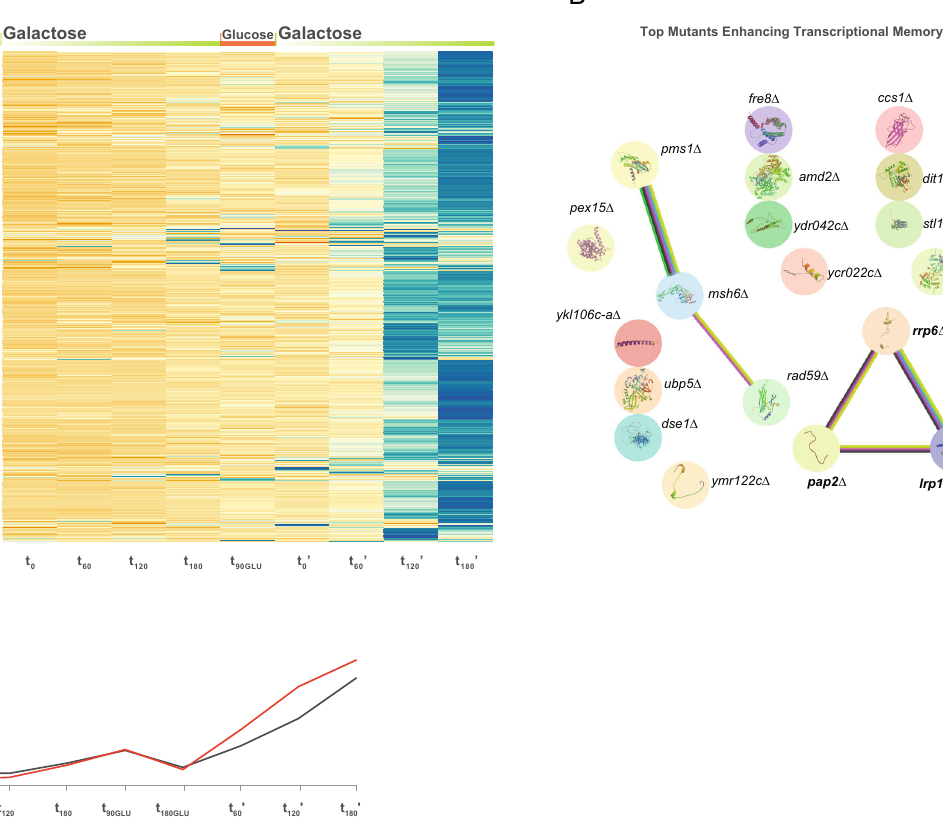
determined, green indicate predicted interaction as gene neighborhood, light greenindicatesourceastextmining,blackindicateco-expression. C RelativesfGFP expression for components of the nuclear exosome in red line ( rrp6 Δ ) relative to wild type in black line (y-axis from 1 (all cells with no detectable GFP) to 4 (all cells with maximum GFP), see Methods for